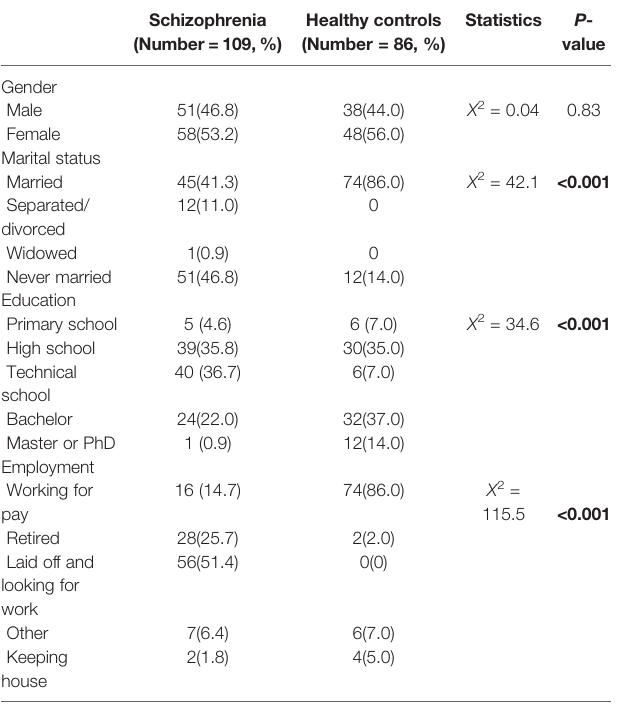
TABLE 1 | Socio-demographic variables between schizophrenia and healthy